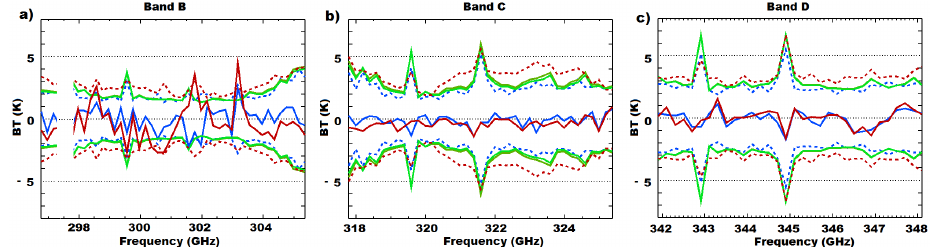
Fig. 4. Average noise level (green), average residuum (solid lines, blue for the best and red for the worse scan) and corresponding standard deviations (dashed lines) for: (a) scans 22 blue and 49 red in band B, (b) scans 12 in blue and 51 in red in band C, (c) scans 29 in blue and 47 in red for band D.